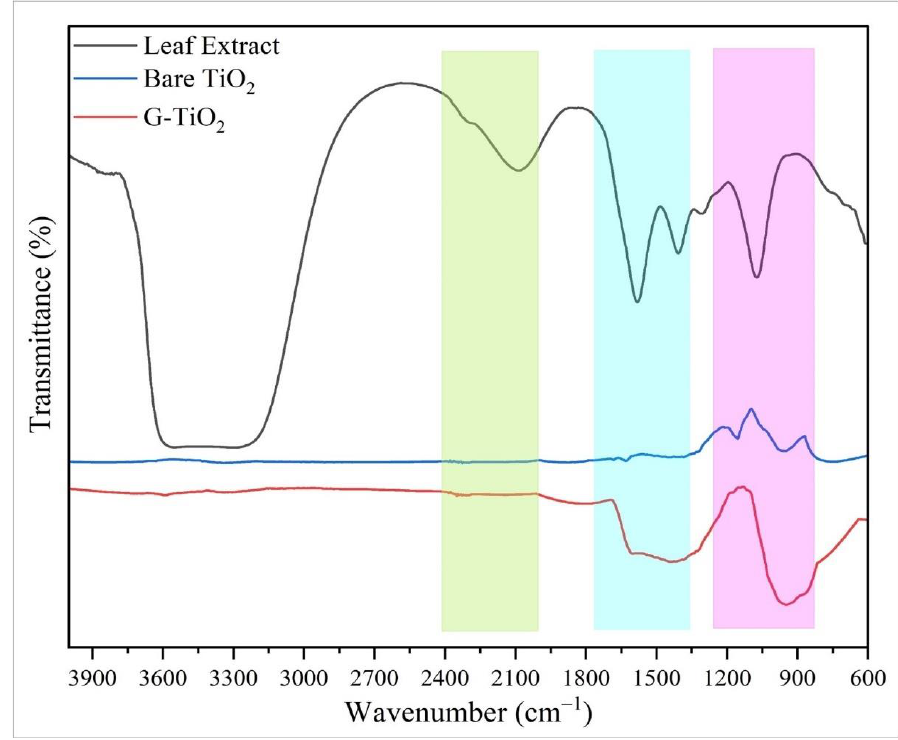
Figure 2. FTIR spectra of leaf extract, bare and biosynthesized TiO 2 nanoparticles.